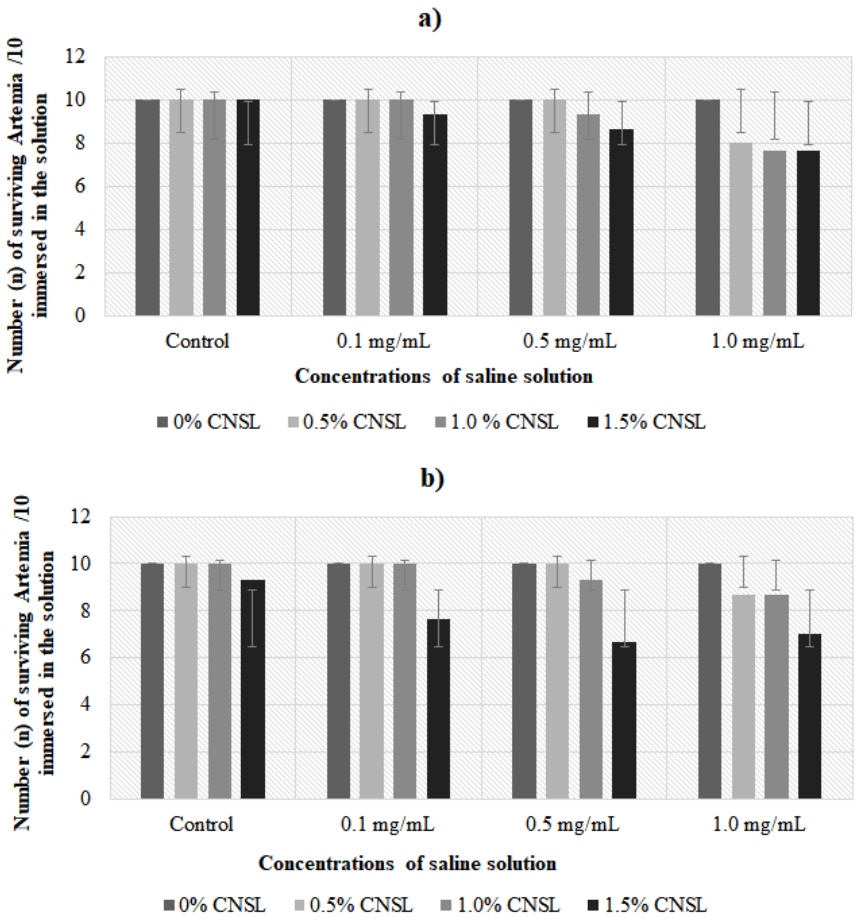
Figure 4. Determination of Artemia larva ( n = 10) ecotoxicity in different salt concentrations from films enriched by different concentrations of cashew nut shell liquid (CNSL) after 24 ( a ) and 48 h ( b ). Values are described as the mean ± standard deviation ( n = 3); SEM = standard error of the mean; difference by the Tukey test when p < 0.05.